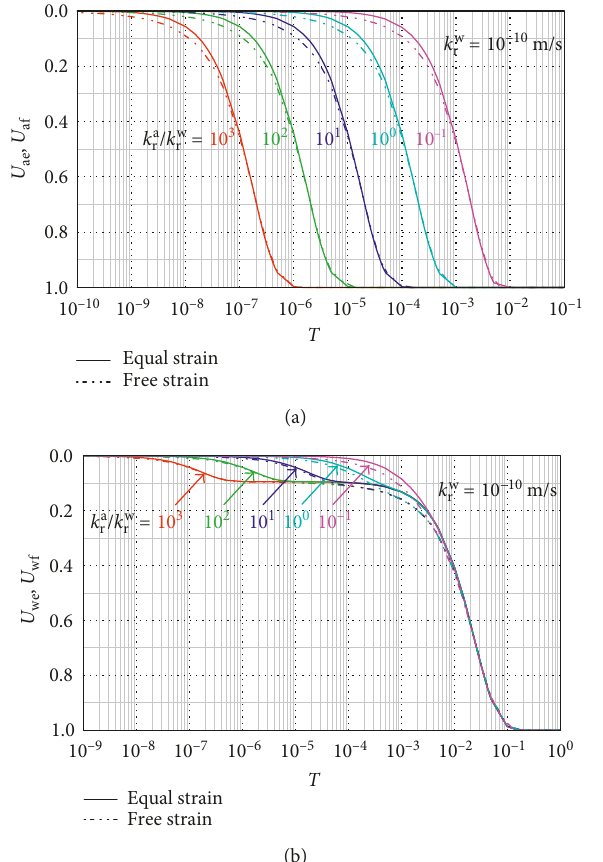
Figure 2: Average degrees of consolidation of (a) air phase and (b) water phase varying with different ratios of k a